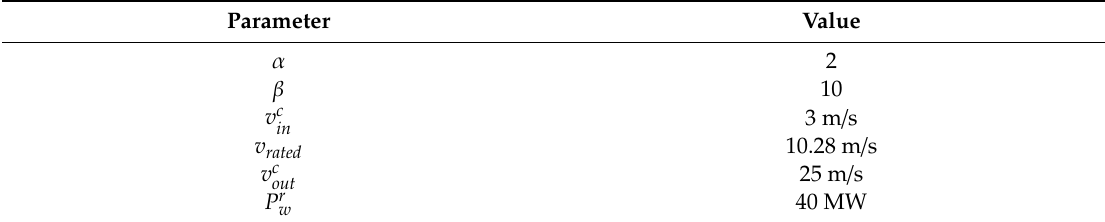
Table A1. Parameters of the wind